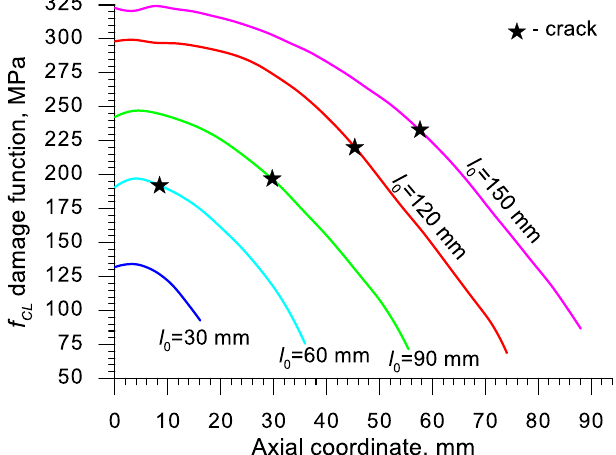
Figure 18. Distributions of the damage function in the axis of a rotationally compressed sample, determined with the use of the Freudenthal criterion.